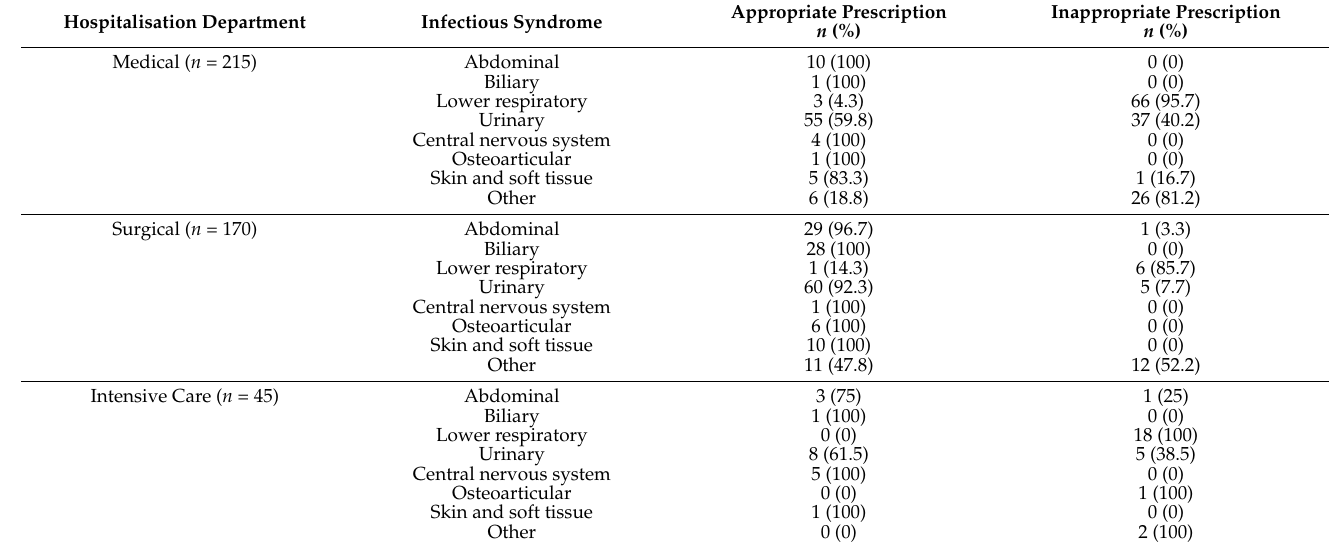
Table 4. Appropriateness of empirical ceftriaxone prescriptions per infection syndrome and department.